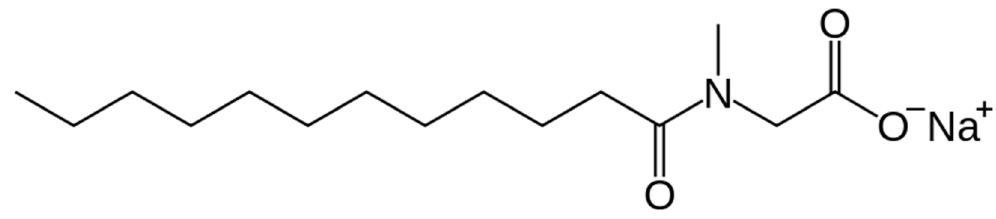
Figure 4. Structural formula of sodium lauroyl sarcosinate.